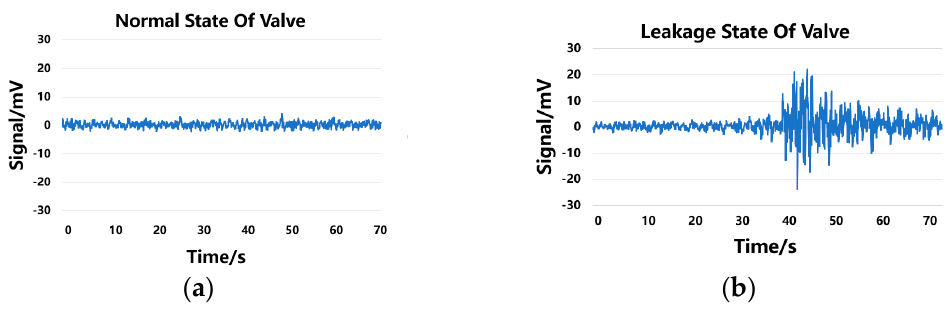
Figure 1. AE signal waveform under valve well − sealed normal conditions and leakage: ( a ) normal state and ( b ) leaked state.